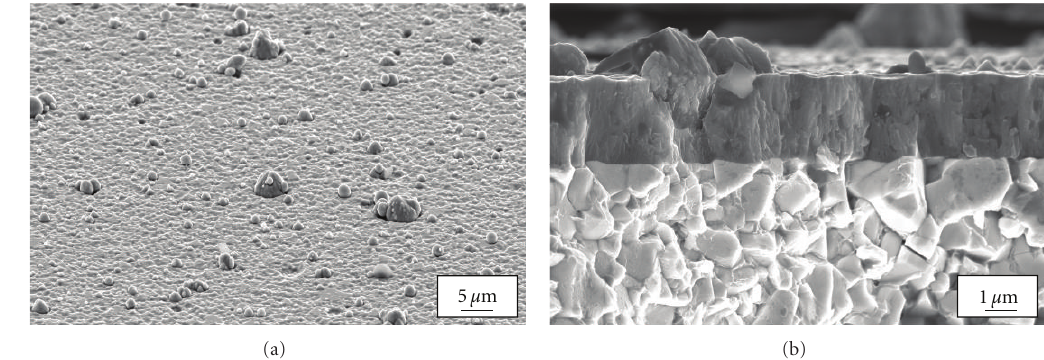
Figure 2: Surface morphology (a) and fractured cross-section (b) of Ti 0 . 34 Al 0 . 66 N coating.